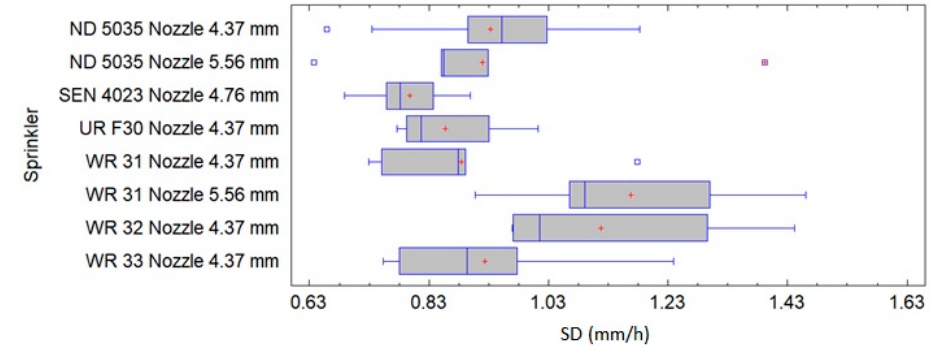
8 of 22 Figure 3. Sprinkler flow measurements. 3.2. Sprinklers’ Water Distribution Patterns The spatial distribution variability was assessed in terms of the standard deviations (SD) of the irrigation water depth (mm/h) collected within each solid-set experiment for each sprinkler type with the data collected from the 25 catch cans and was summarized as a box-whisker plot in Figure 4. The total number of solid-set experiments was 60. The number of trials per sprinkler showed in Figure 4 could be seen in the Appendix A and they varied between 6 and 9 tests per sprinkler. Moreover, the significant differences found were analyzed using the Fisher´s LSD test at p = 0.05. The effect of the pressure on the water distribution SD was also analyzed